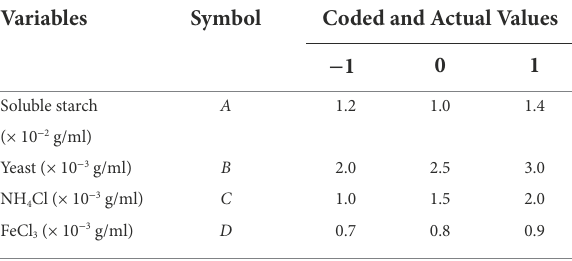
TABLE 1 Coded and actual values of the variables for the four-factor Box–Behnken experimental design.